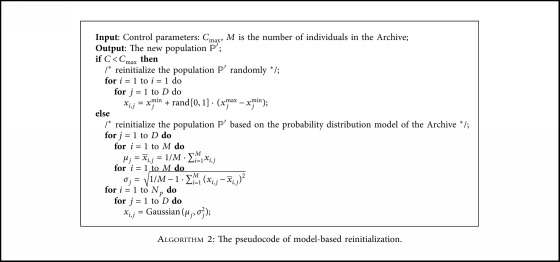
 The pseudocode of model-based reinitialization.